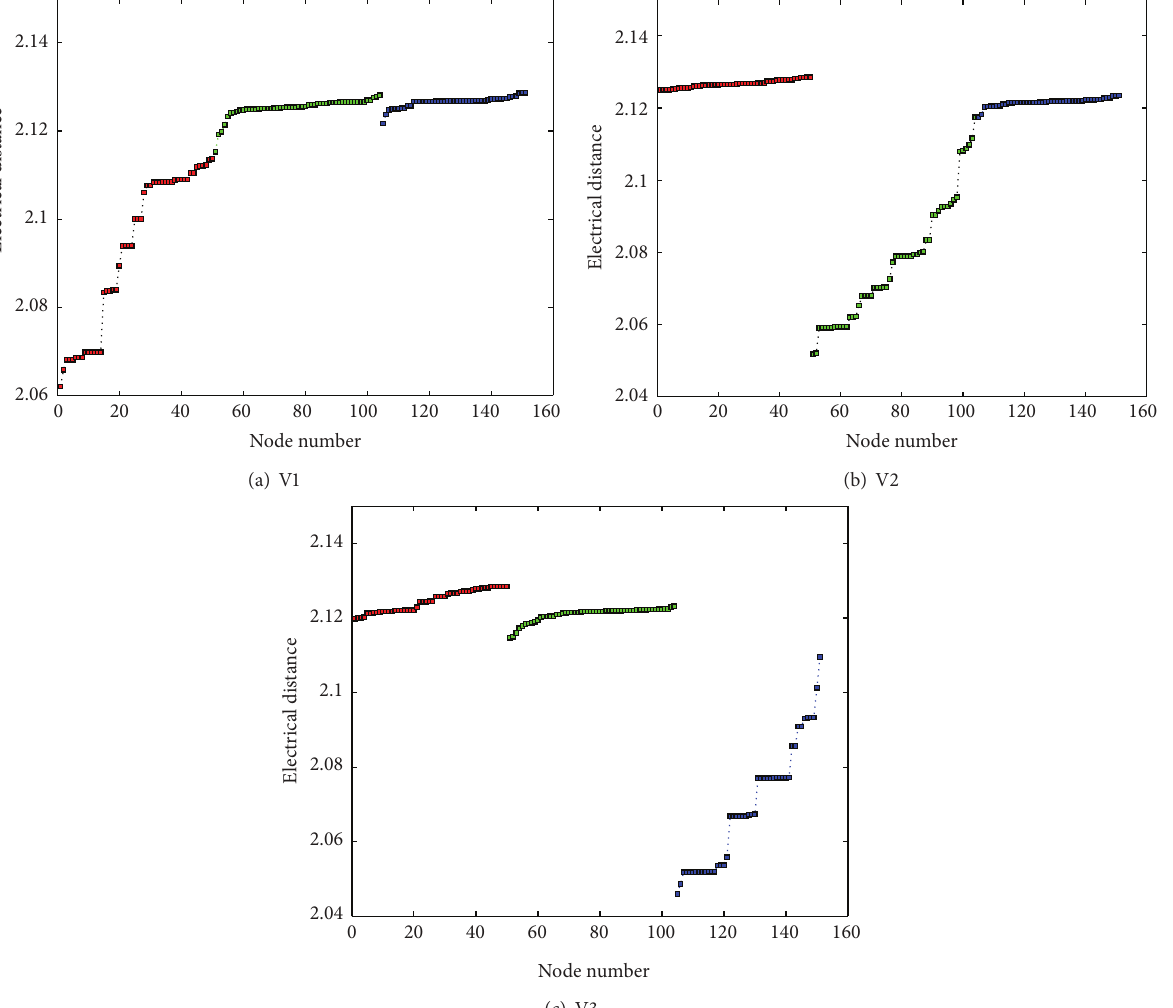
Figure 10: Electrical distance distribution between V1, V2, and V3 and other nodes. Red squares represent the electrical distance between the selected node and nodes in Zone1. Green squares represent the electrical distance between the selected nodes and nodes in Zone2. Blue squares represent the electrical distance between the selected node and nodes in